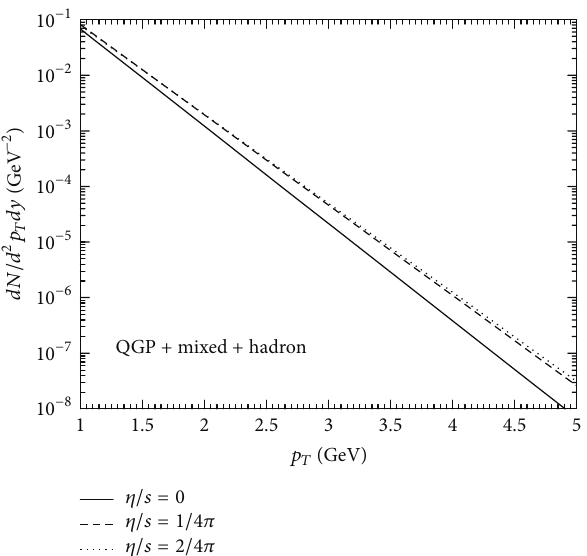
Figure 16: Transverse momentum distribution of thermal photons from the entire evolution history of the system for various values of 𝜂/𝑠 in the scenario